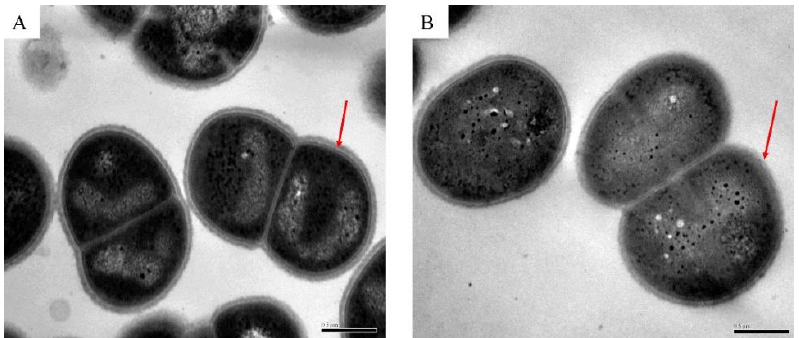
Figure 2. Transmission electron microscopy (TEM) images of D. radiodurans cells ( A ) under normal growth conditions and ( B ) following exposure to 80 mM H 2 O 2 for 30 min. Bar: 500 nm. The red arrow points to the cell wall and cell membrane.